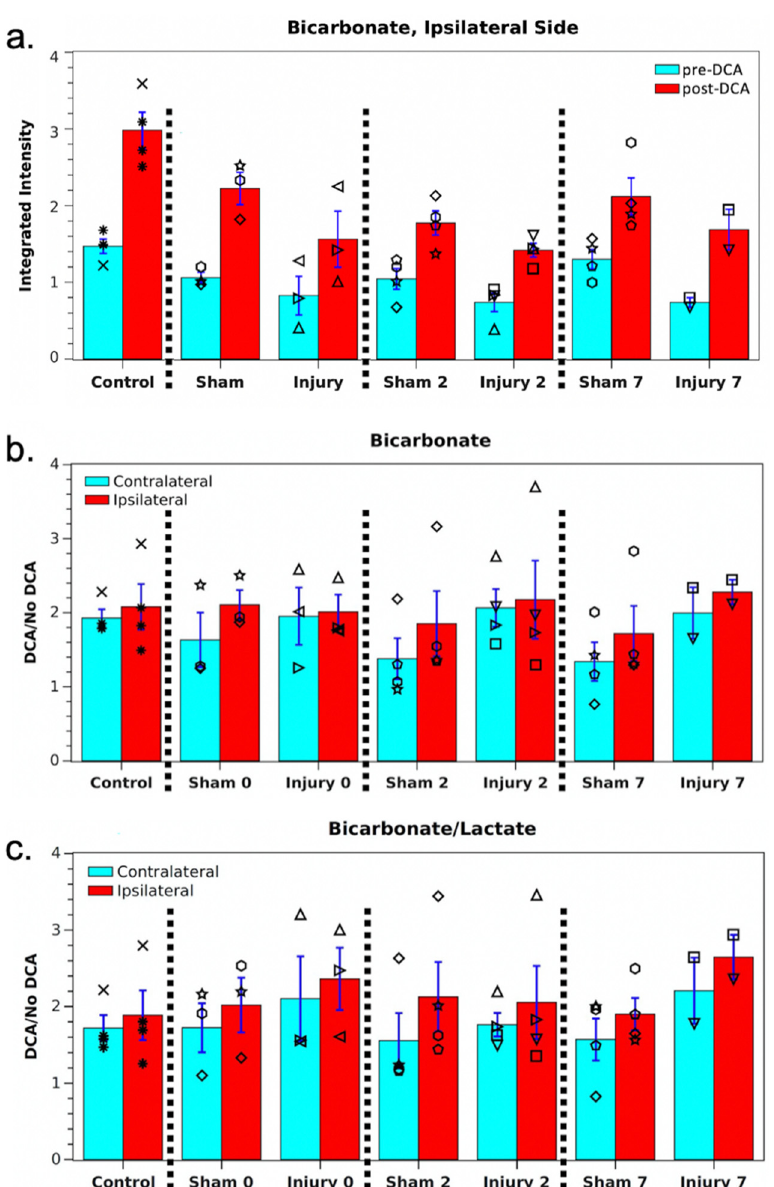
Figure 3. ( a ) Mean ipsilateral bicarbonate for the cohort pre- and post-DCA. Individual measure- ments are shown by black symbols, and each rat has been assigned its own symbol. ( b , c ) Mean bicarbonate and bic/lac signal enhancements for the cohort following DCA administration. None of the measurements showed a significant difference between hemispheres or versus controls.